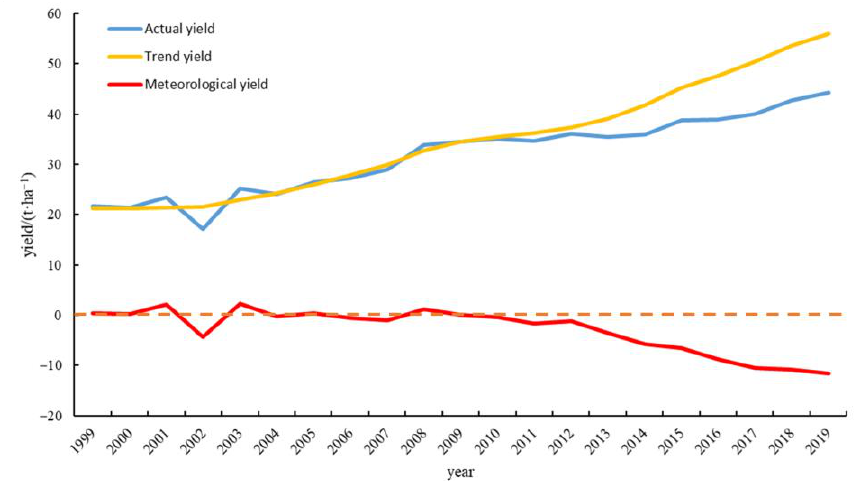
Figure 2. Actual, trend and meteorological yield of Yantai apples from 1999 to 2019 (the orange line in the figure where the meteorological yield is equal to 0 t · ha − 1 is the dividing line where the meteorological yield plays a facilitating or inhibiting role in the actual yield. If it is higher than the orange line, it plays a facilitating role in the actual yield; conversely, if it is lower than the orange line it plays an inhibiting role in the actual yield.